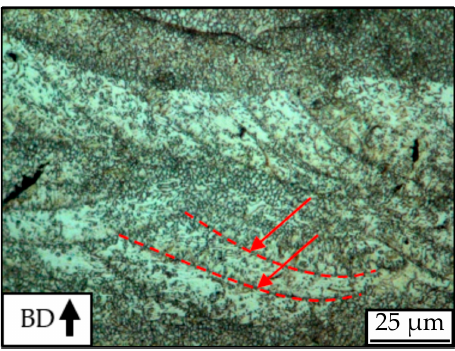
Figure 12. Region poor in intergranular intermetallic network, sample of batch A Mg . Etchant: Nital 2%.; red lines show interfacial precipitation.